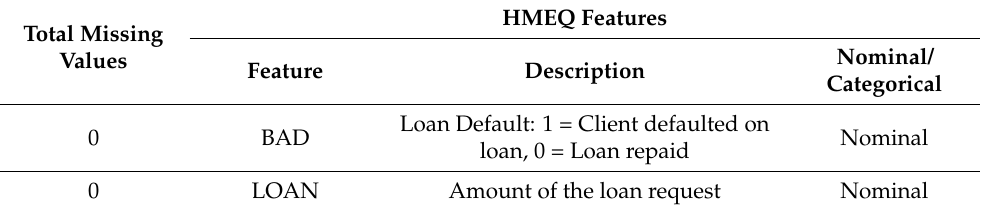
Table 1. Housing price